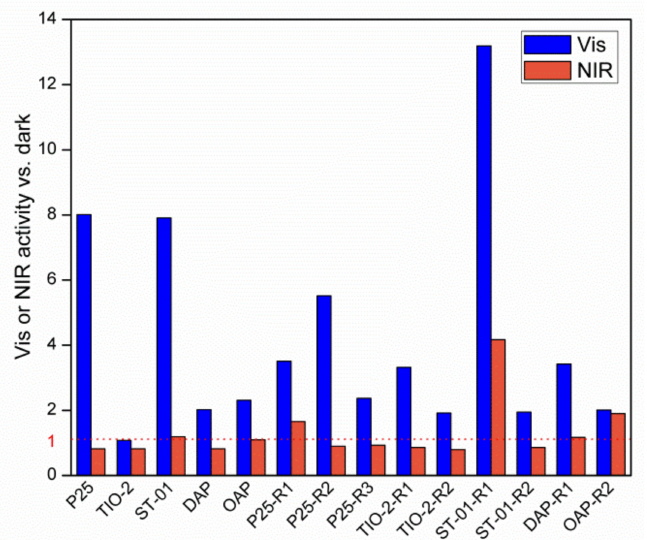
Figure 9. The relative activity under vis (blue) and NIR (orange) for phenol photodegradation on pristine and reduced titania samples.